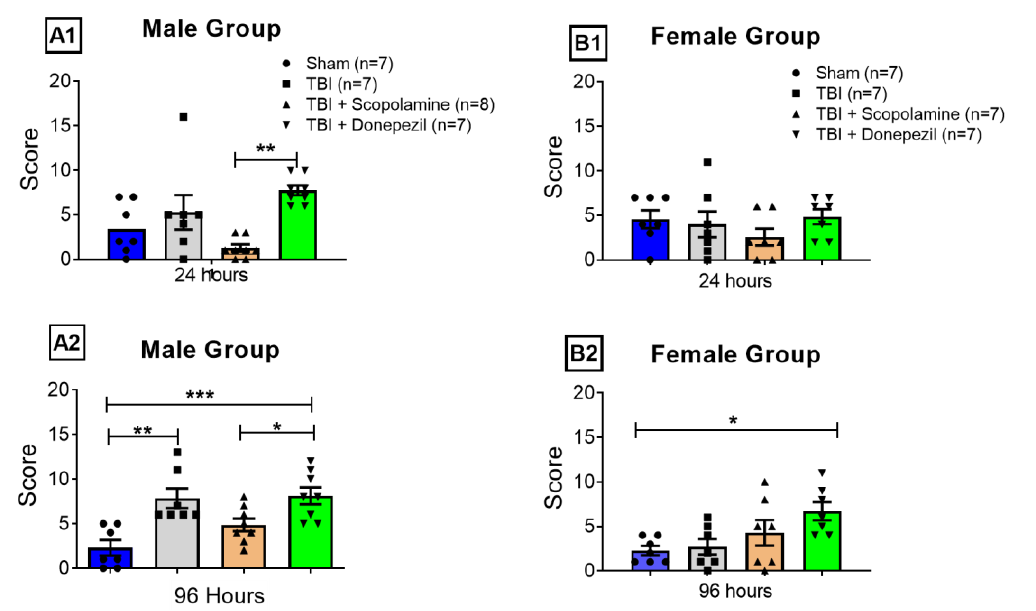
Figure 2. Neurological severity scoring of TBI mice. ( A1 , B1 ) show the neurological scores of the male and female mice 24 h post-trauma, respectively. ( A2 , B2 ) show the neurological severity scores of the male and female mice, respectively, 96 h after trauma. Data were analyzed using one-way ANOVA and are presented as mean ± SEM. * p < 0.05, ** p < 0.001 and *** p < 0.0001. TBI: traumatic brain injury, n : number of mice per group.